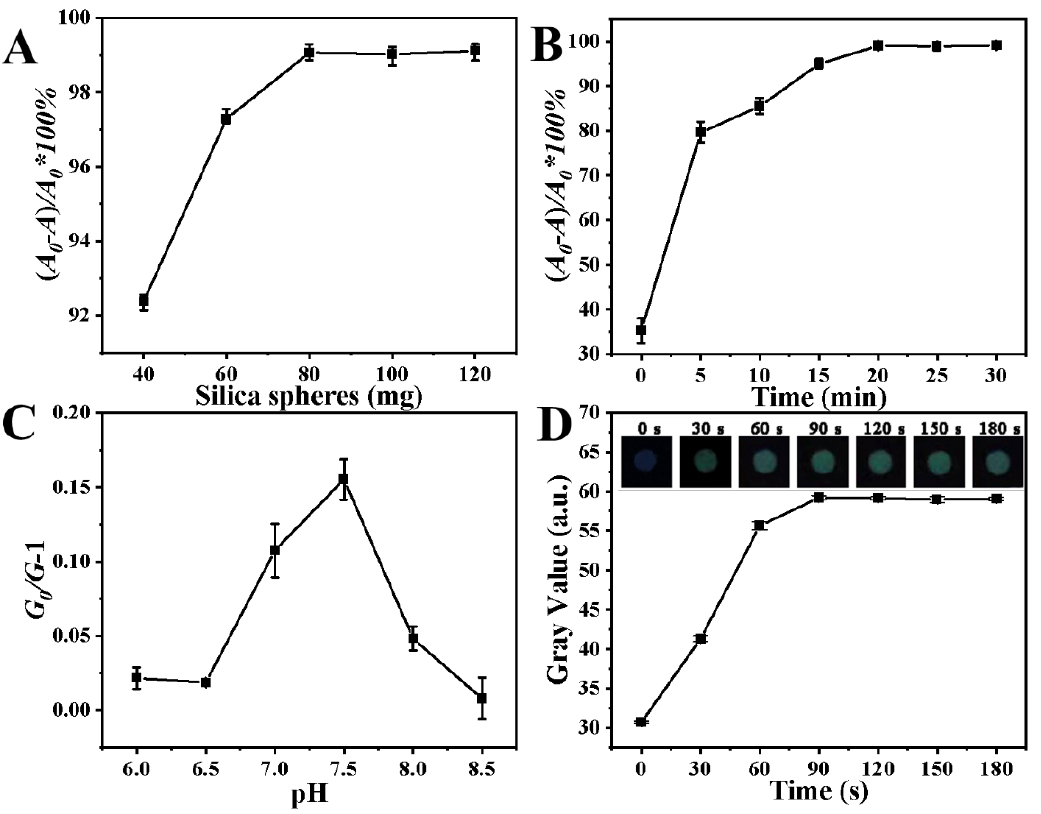
Figure 3. ( A ) Influence of the amount of silicon nanomaterials on the grafting rate of QDs. ( B ) Influence of the grafting time on the grafting rate of QDs. ( C ) Influence of pH on the quenching effects of QDs. ( D ) Fluorescence gray values of QDs–SiO 2 versus time within 180 s, where the Hg 2+ concentration was 50 µ g/L, the excitation wavelength was 396 nm and the slit widths were 5